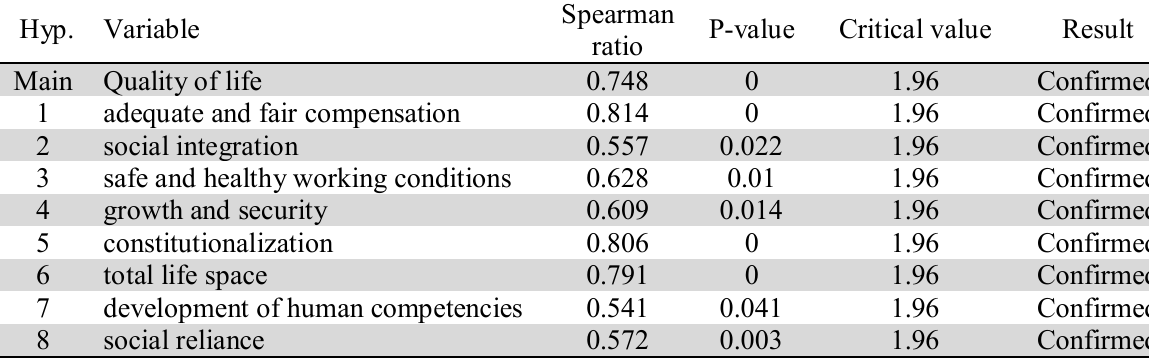
The summary of Spearman correlation